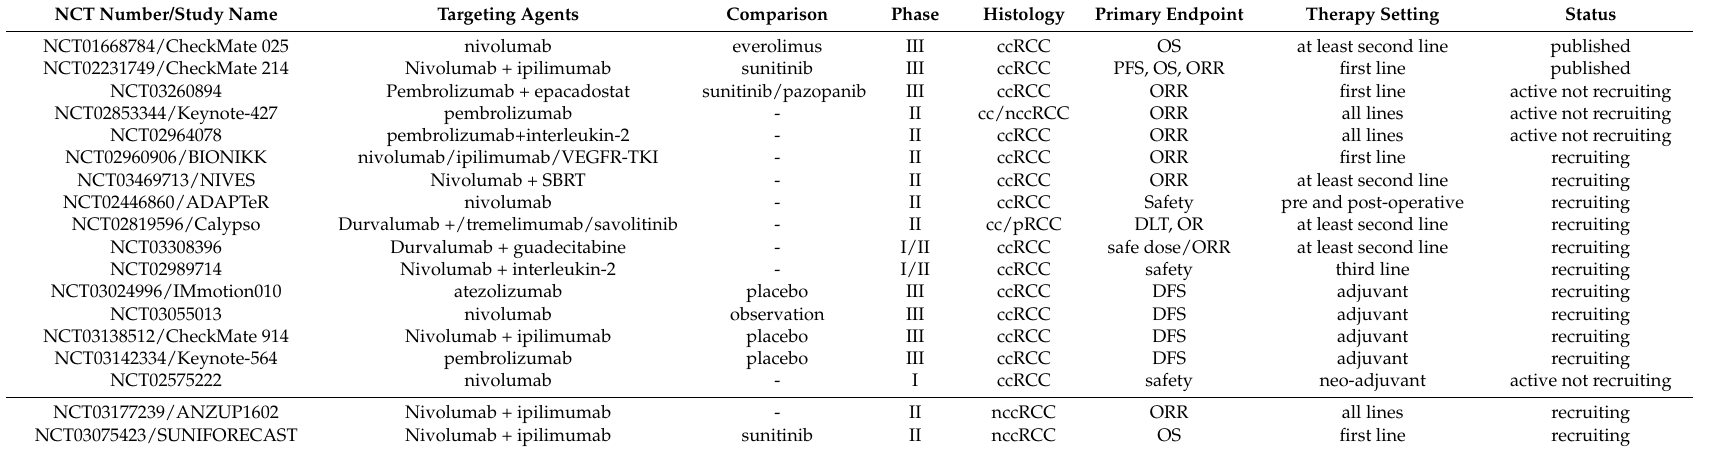
Table 2. Clinical trials evaluating immune checkpoint inhibitors alone or in